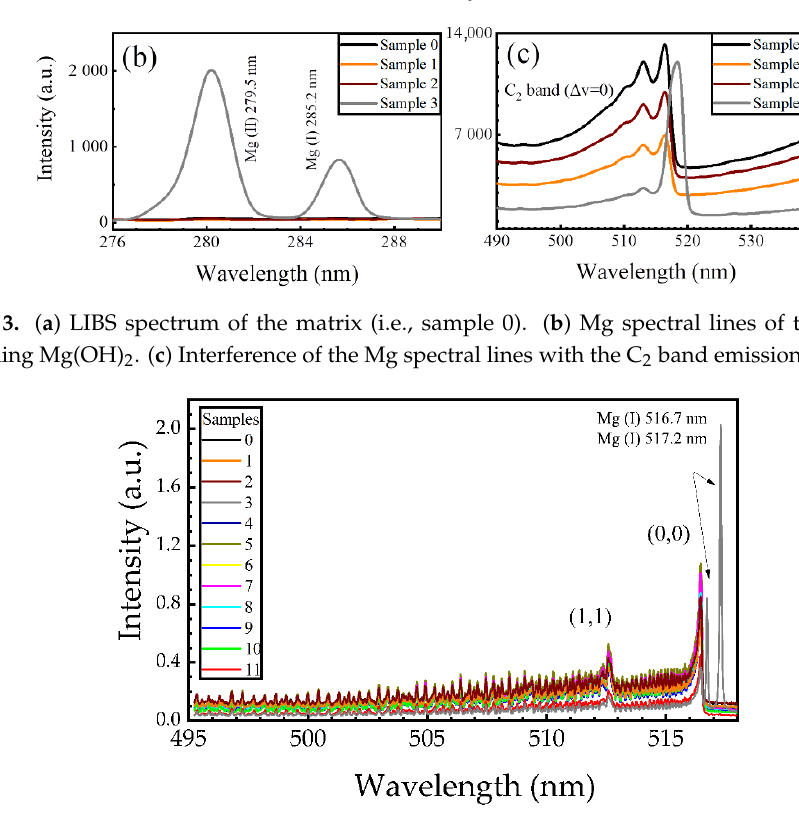
Figure 4. C 2 Swan band ( Δ v = 0) spectra of the polymers.